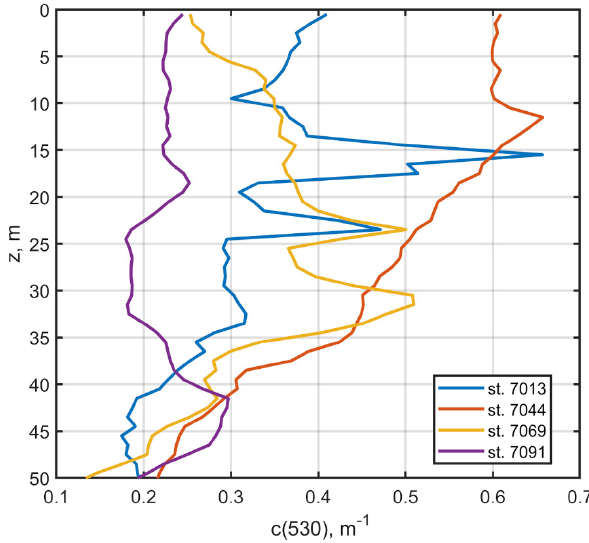
Figure 5. Measured c (530, z ) vertical profiles for the selected stations.